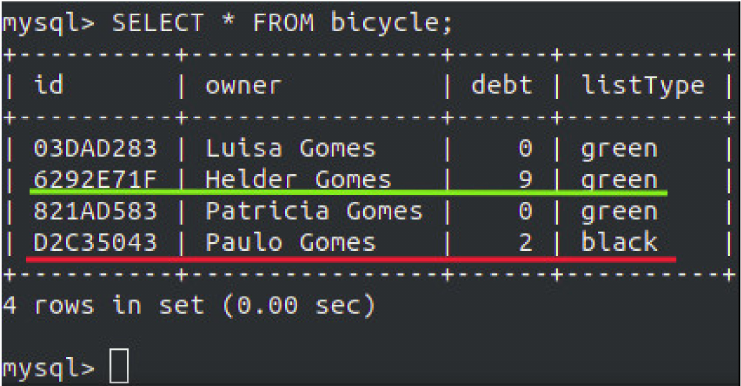
Figure 7. MySQL shell with four registered